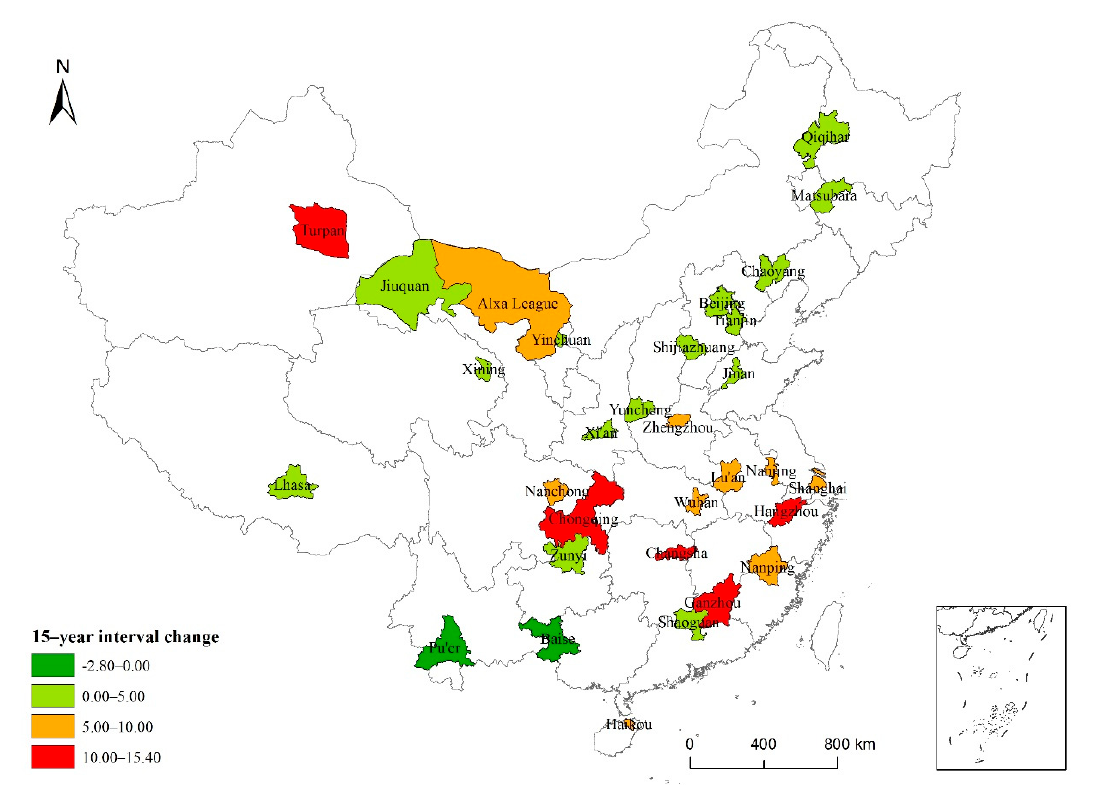
Figure 4. Map of China showing the 15-year interval variation of high-temperature weather in typical cities. Table 3. Time series analysis of high-temperature days from 1986 to 2015.